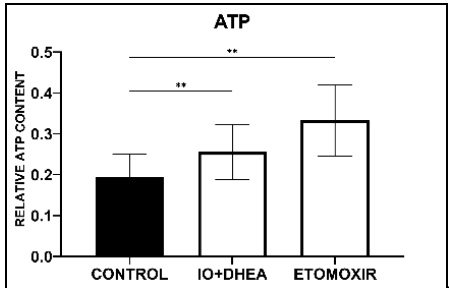
Figure 3. The effect of glucose (IO+DHEA) and fatty acid (ETOMOXIR) metabolism inhibition on ATP content in oocytes (means ± SD). **— p ≤